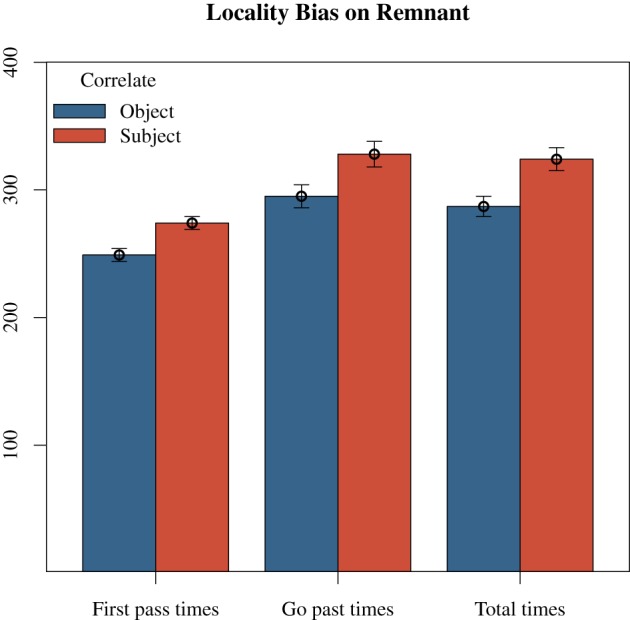
Experiment 2: effect of Locality on the remnant region. Times presented in ms.